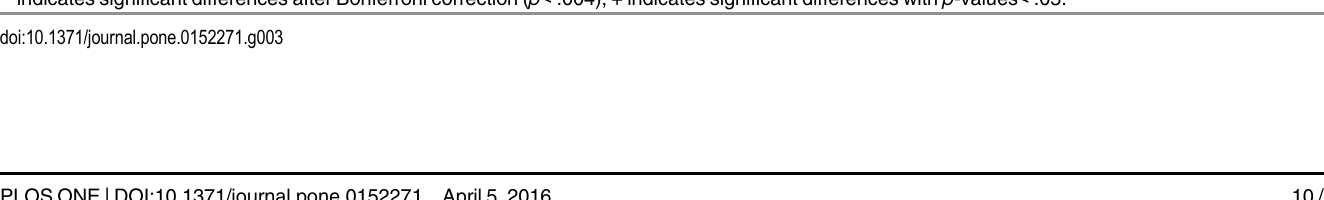
PLOS ONE | DOI:10.1371/journal.pone.0152271 April 5,